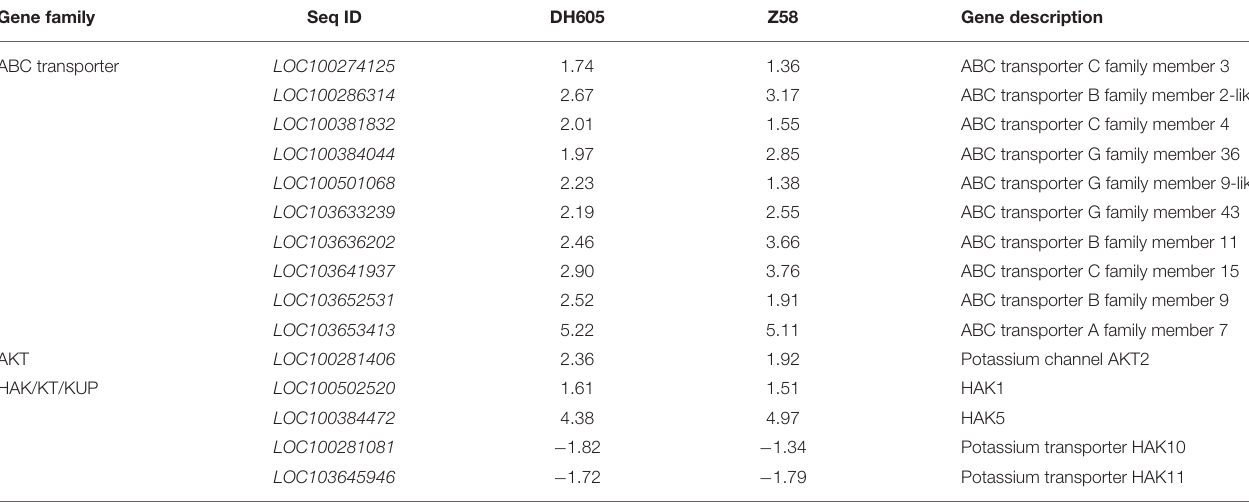
TABLE 1 | Genes encoding transporters showed differential expression in response to K + deficiency (0.1mM). Gene family Seq ID DH605 Z58 Gene